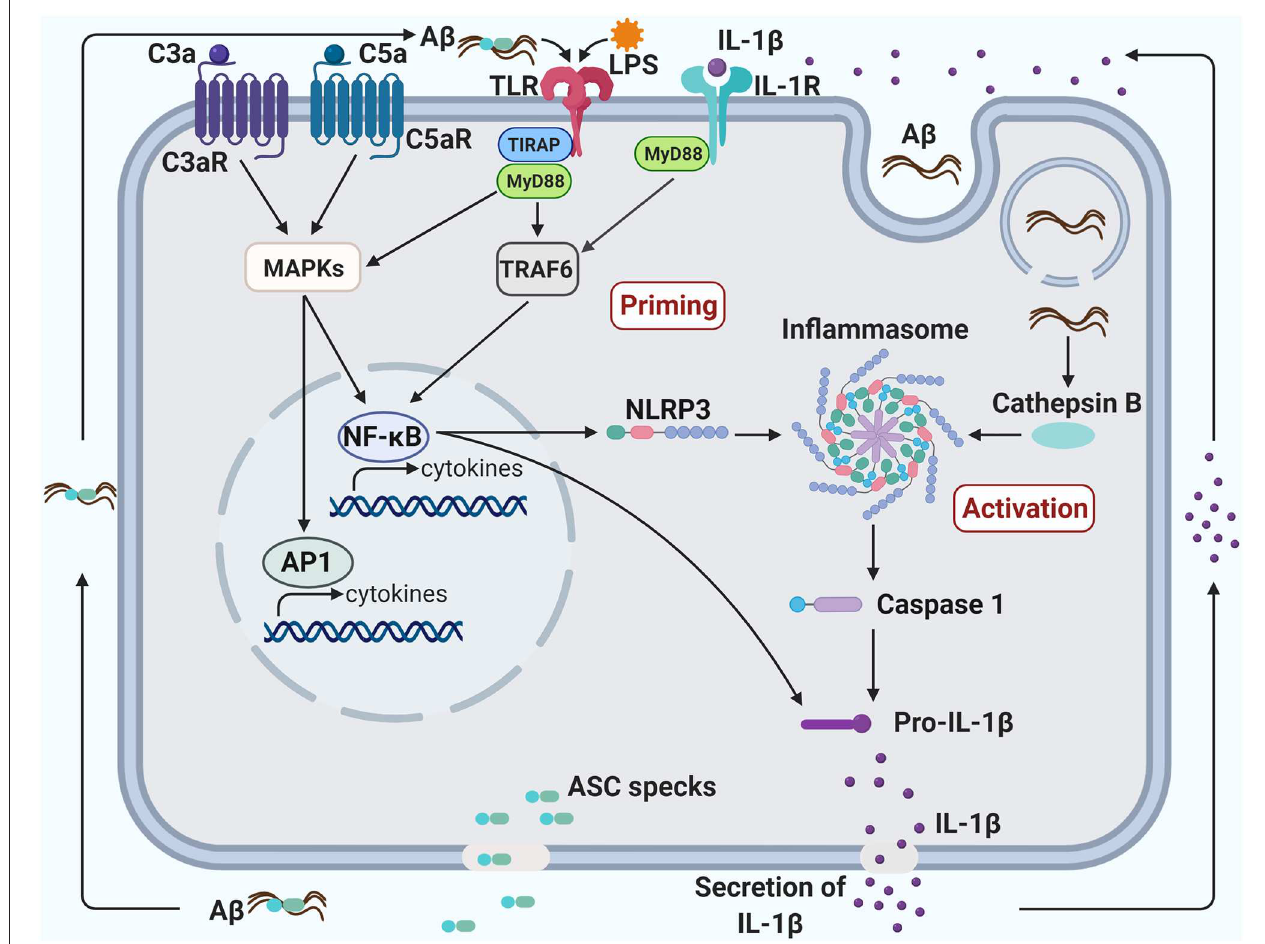
FIGURE 2 | Crosstalk between TLR4, NLRP3 inflammasome, and complement promotes neuroinflammation in Alzheimer’s disease. Priming of the inflammasome occurs when the transcription factor, NF- k B, is activated, triggering the production of both NLRP3 and Pro-IL-1 β . NF- k B can be activated via the TLR/IL-1R MyD88-dependent pathway and the C3/C5 MAPK pathway. The TLR pathway can be induced by a bacterial component, such as LPS, and the MAPK pathway can be induced by C3a/C5a binding to their respective receptors. The activation of NF- k B through complement, TLR and IL-1R pathways may create a synergistic increase in pro-inflammatory factors. The inflammasome can be activated in several ways, including an increase of endogenous damage-associated and pathogen-associated molecular patterns or an efflux of potassium or chloride ions. Additionally, aggregated fibrillary A β engulfed by the microglia can damage the lysosome and leak into the cytoplasm, also contributing to the activation of the inflammasome. Activation of the inflammasome can induce pyroptosis, leading to the secretion of IL-1 β and ASC specks. ASC specks bind to A β and seed the surrounding parenchyma leading to further A β aggregation. Aggregated A β can also bind to TLR and induce activation of the MyD88 pathway. Likewise, IL-1 β secreted from the pyroptotic microglia can bind to IL-1R and induce activation of the MyD88 pathway. The induction of the MyD88 pathway through the by-products of microglial pyroptosis may lead to a vicious cycle of inflammasome priming, inflammasome activation and pyropotosis that will exacerbate A β